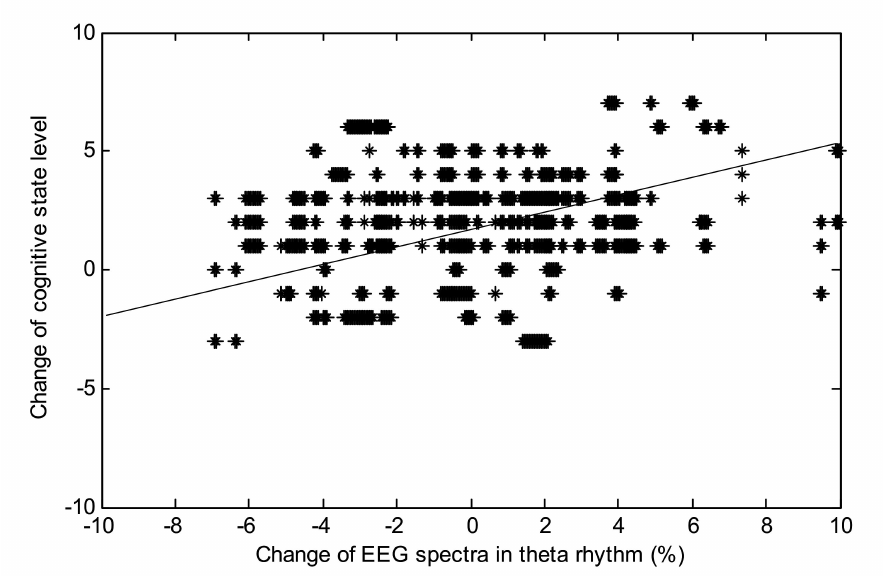
Figure 6. The relationship between cognitive state and theta